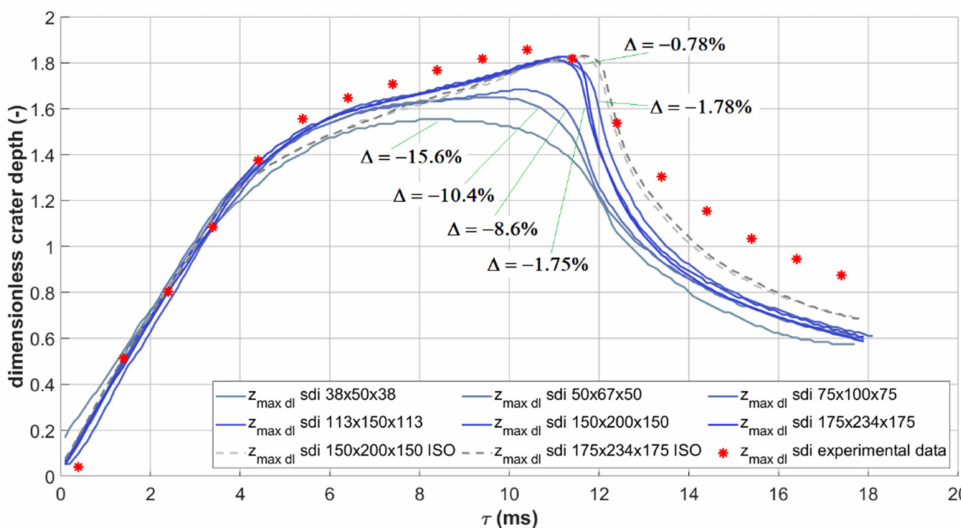
Figure 5. Dimensionless crater depth as a function of time for single drop impact at 1.4 m/s, simulations vs. the experiments reported in [8]. The results with different mesh resolutions are shown to evidence the mesh independence. The percent deviations between the simulated and experimental maximum crater depths with the selected meshes are also